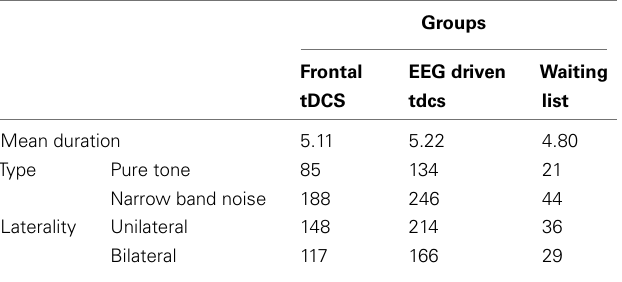
Table 1 |Tinnitus